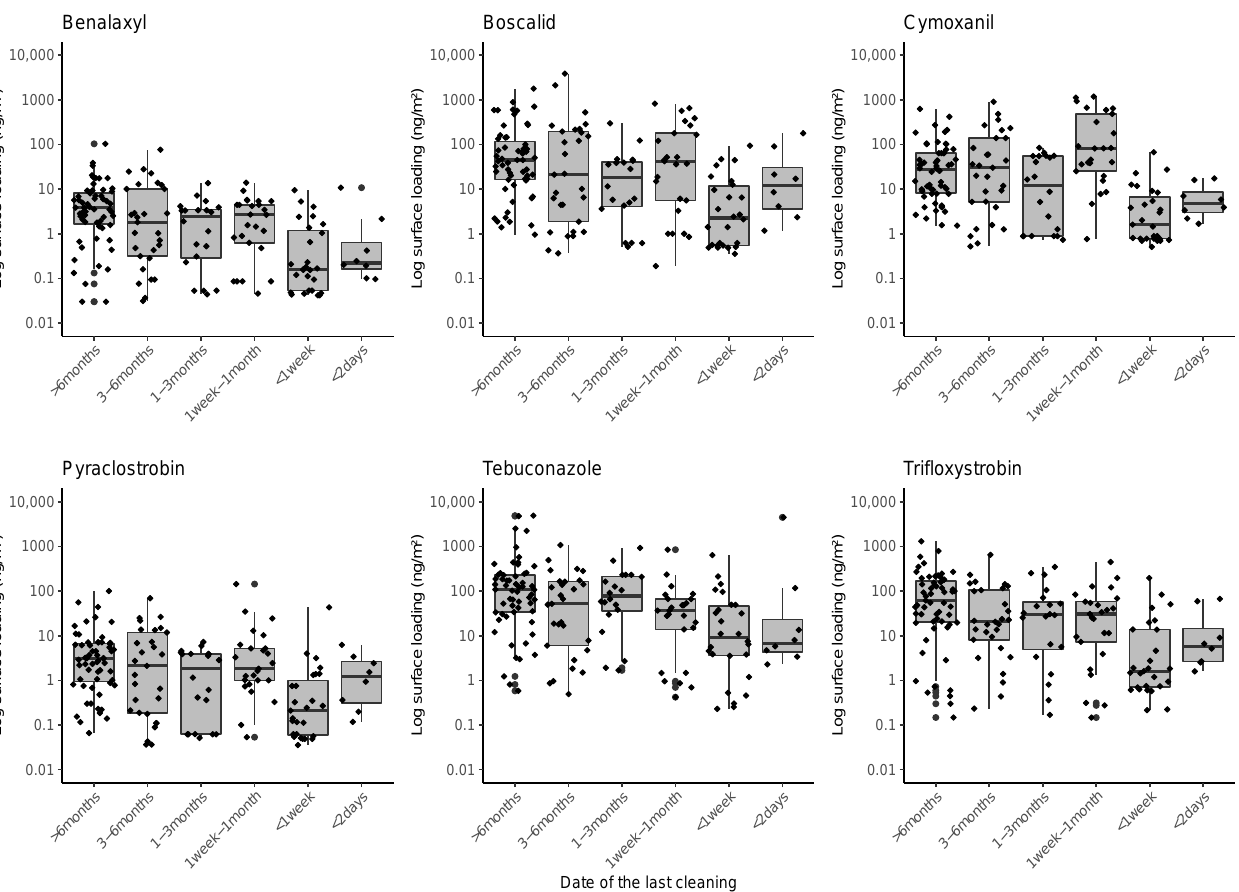
Figure 3. Log—pesticide surface loadings (ng/m 2 ) according to the time of the last cleaning (N =